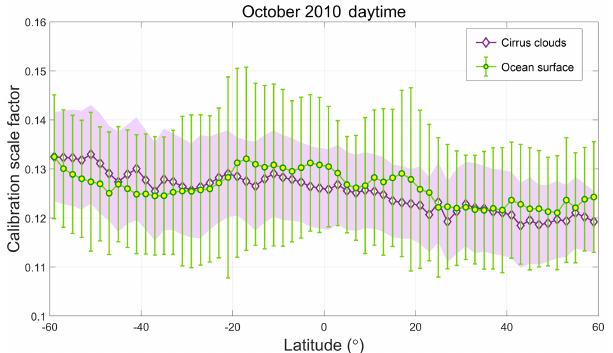
Figure 23. Median 1064nm calibration scale factors computed us- ing cirrus clouds (purple diamonds) and ocean surface measure- ments (green circles) for daytime measurements acquired between 60 ◦ S and 60 ◦ N during October 2010. The pale-purple-filled region indicates ± 1 median absolute distance (MAD) about the median cir- rus cloud scale factors. Likewise, the green bars indicate ± 1 MAD about the median ocean surface scale